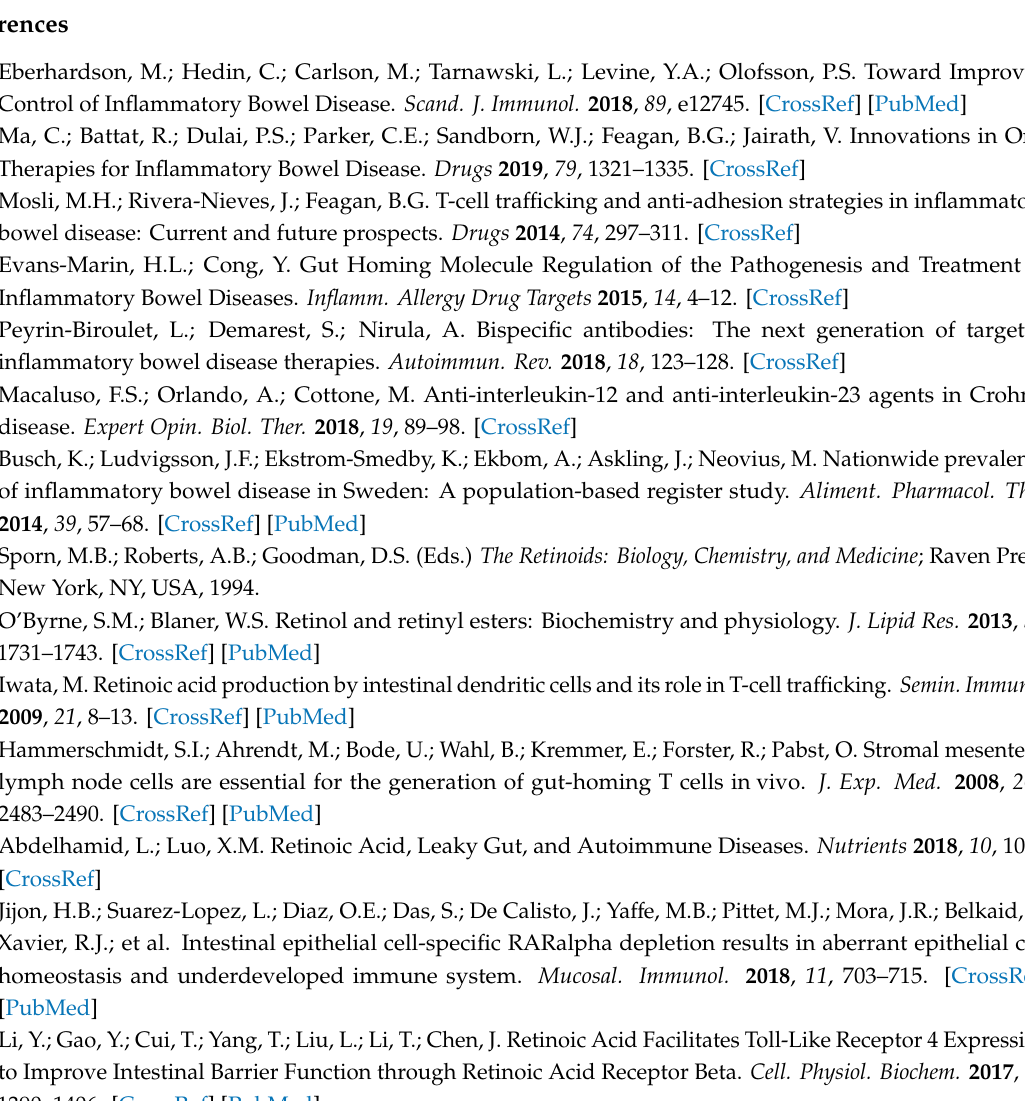
Figure S1: Gating strategies for activated α 4 β 7 + T cells in the MLN (Stain 1), Figure S2: Gating strategies for activated α 4 β 7 + T cells in LPL (Stain 1), Figure S3: Gating strategies for Stain 2, Tregs (Foxp3 + ) and Th17 cells (ROR γ t + ) in the inflammation experiment, Figure S4: Gating strategies for IC cytokine stains (Stain 3), Figure S5: Alteration of T cell phenotypes due to WIN 18,446 treatment during steady state (repeat experiment of Figure 2), Figure S6: CD44 vs. α 4 β 7 integrin staining in steady state MLN T cells from control diet vs. WIN 18,466-treated mice, Figure S7: Supplementary data complementing Figure 3 of the inflammation T cell subsets